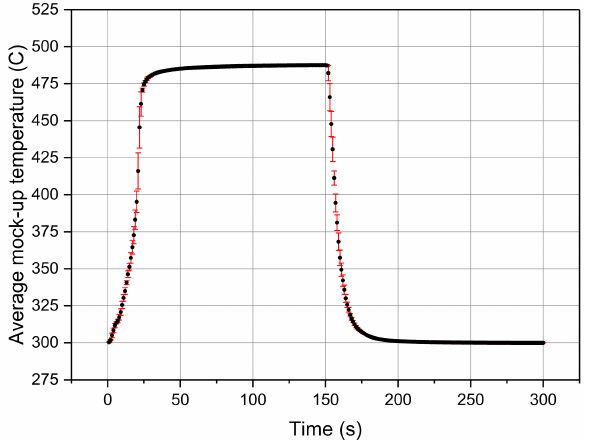
Figure 10. Temperature evolution at the mock-up thermocouple position averaged over 15 cycles during a run from 5 August 2019 for FG